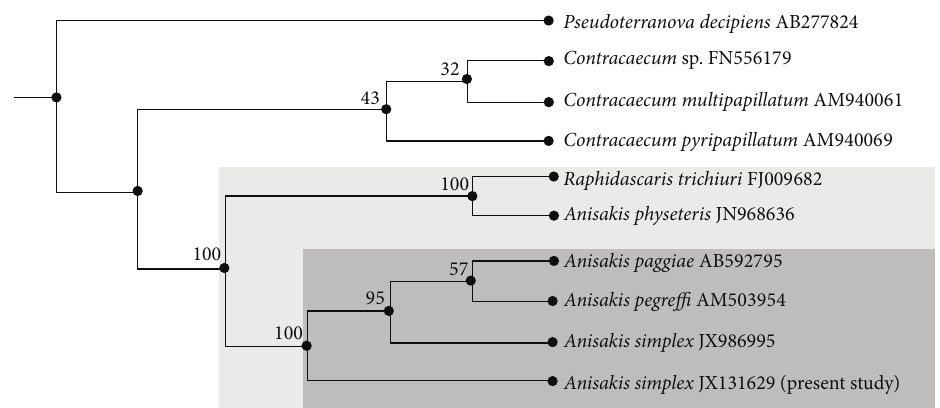
Figure 4: Dendrogram based on SSU rDNA gene sequences showing the phylogenetic relationship between A. simplex (L3) and other Anisakidae species. Bootstrap percentages of clades as inferred by ML shown above internal nodes. The SSU rDNA gene sequences of Pseudoterranova decipiens were used as an